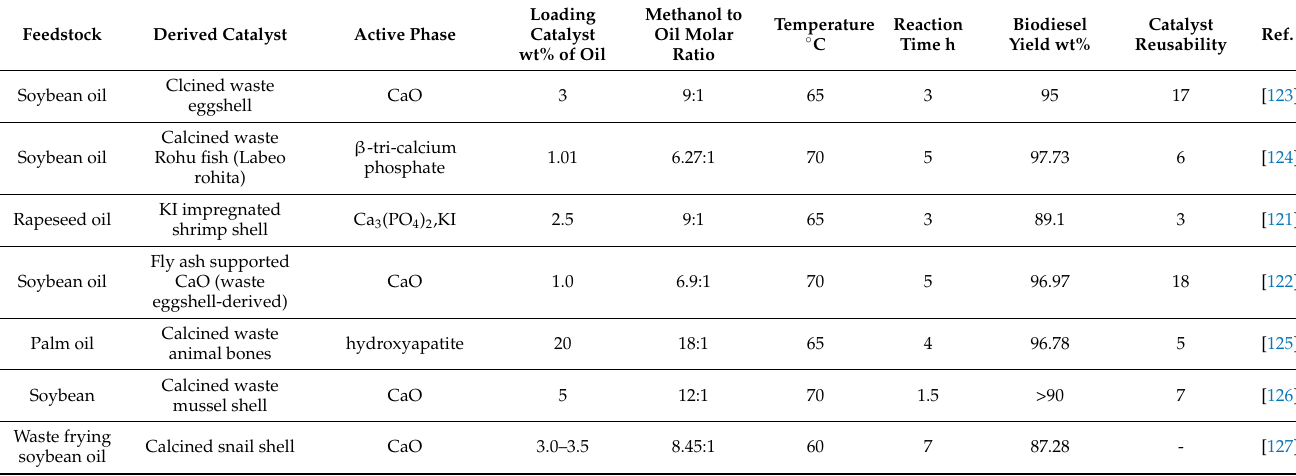
Table 5. Biodiesel production by solid base catalysts derived from industrial wastes.